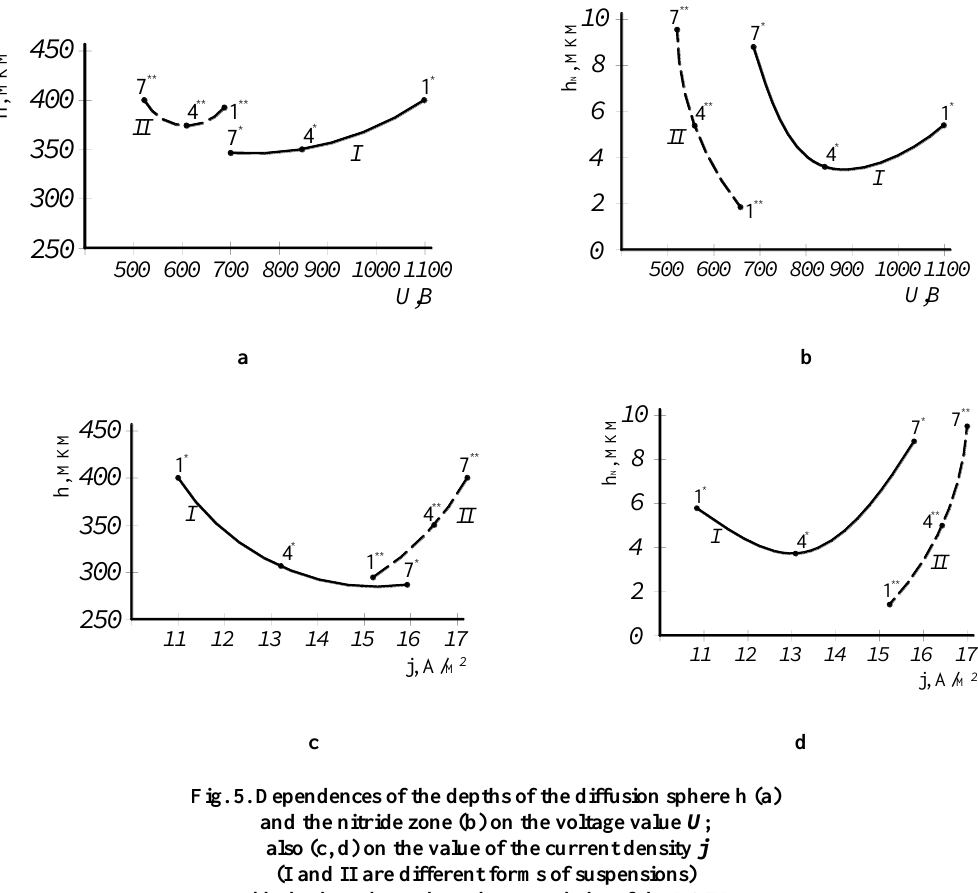
Fig. 5. Dependences of the depths of the diffusion sphere h (a) and the nitride zone (b) on the voltage value U ; also (c, d) on the value of the current density j (I and II are different forms of suspensions) with the interdependent characteristics of the